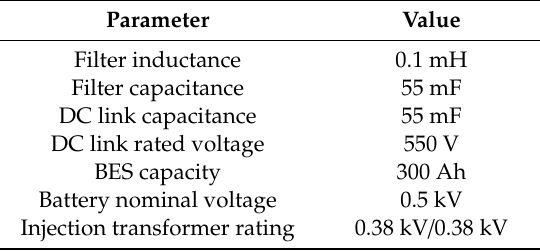
Table 2. BES-based DVR parameter